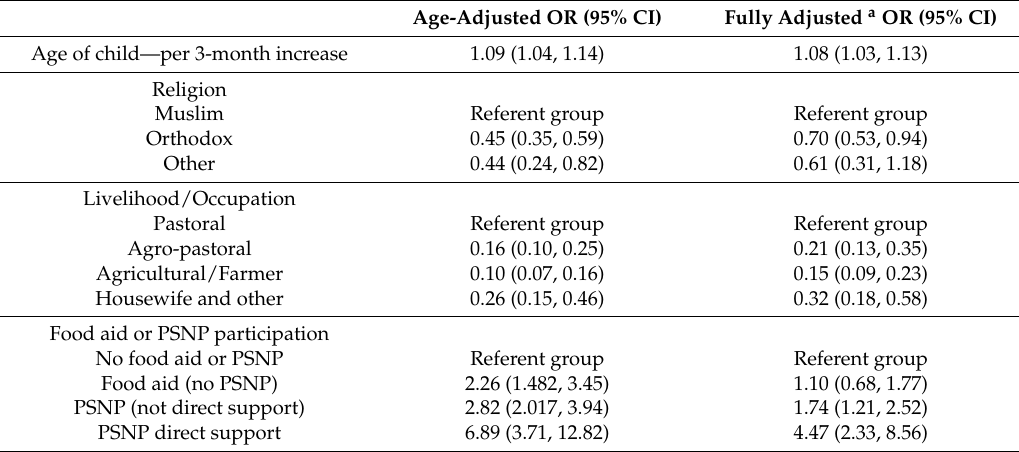
Table 2. Adjusted odds ratios for consumption of animal source foods by religion, livelihood, and food aid or safety net participation ( n =